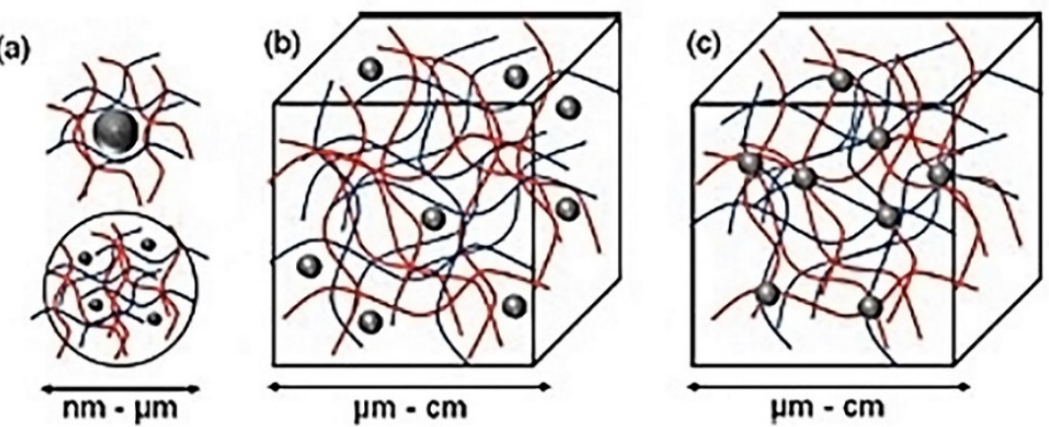
Figure 1. ( a ) The nanoparticle or microparticle stabilizing an inorganic polymer matrix or other polymer nanoparticles. ( b ) Nanoparticles non-covalently dispersed in a hydrogel matrix. ( c